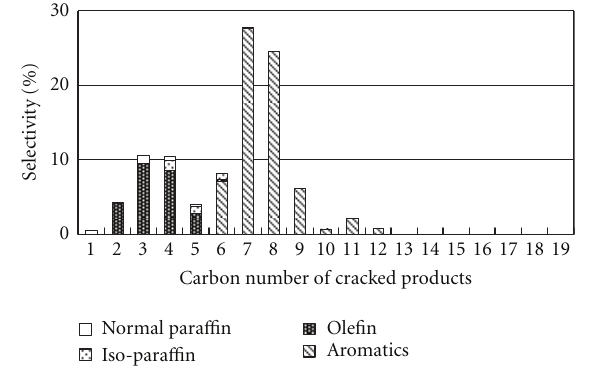
Figure 12: Product distribution of catalytic cracking of hydrotreated oil over ns Al 2 O 3 /H-GaAlMFI catalyst at 500 ◦ C (contact time: 0.05